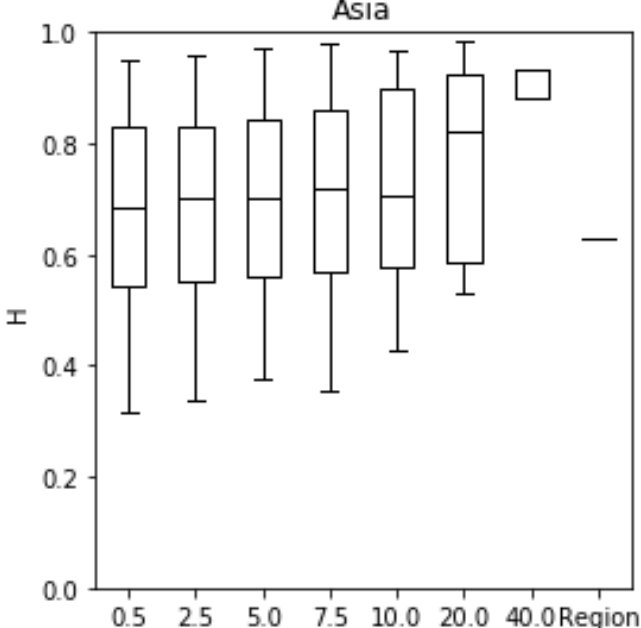
Figure 6. Box plot showing scale dependence of H for the Asian region. Units for x -axis are decimal degrees.